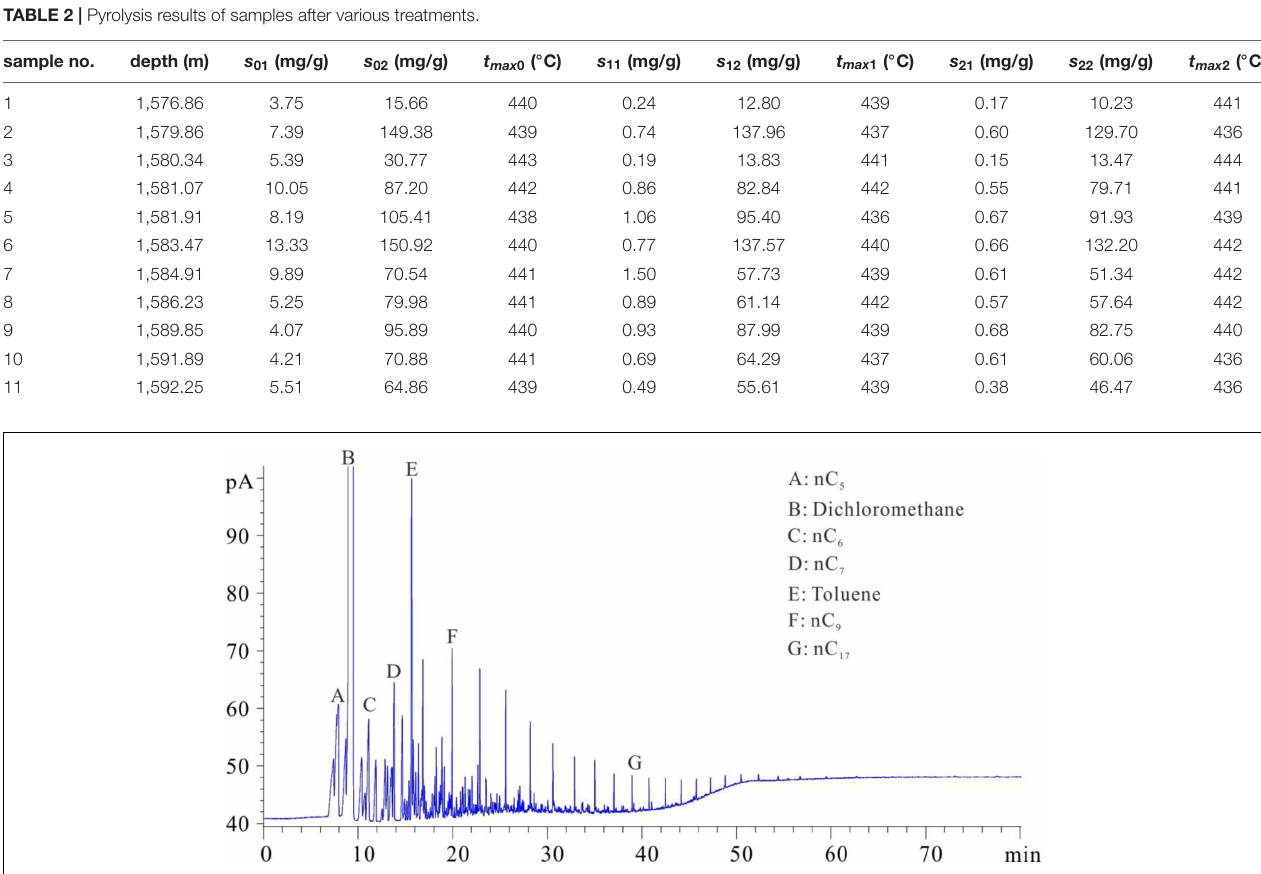
FIGURE 1 | Chromatogram of samples that were soaked first and then crushed (chromatogram after step 1).